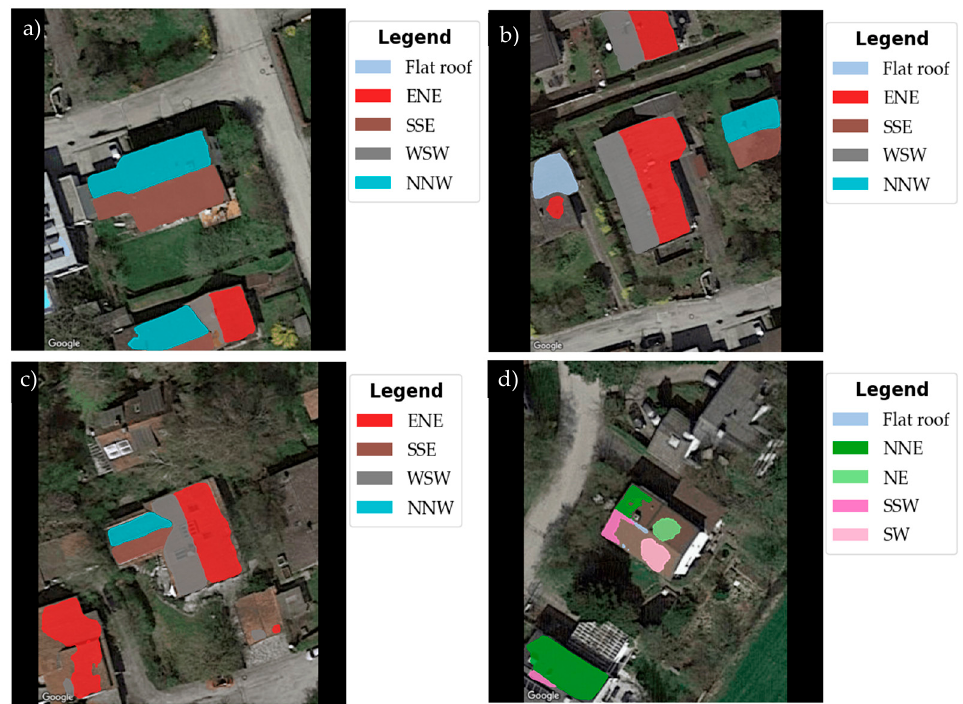
Figure 5. Example results of the roof segmentation, ( a , b ) show correct segmentation, ( c ) shows mediocre segmentation, and ( d ) show incorrect segmentation results. Labels: ENE: east-north-east, SSE: south-south-east, WSW: west-south-west, NNW: north-north-west, NNE: north-north-east, NE: north-east, SSW: south-south-west, SW: south-west.